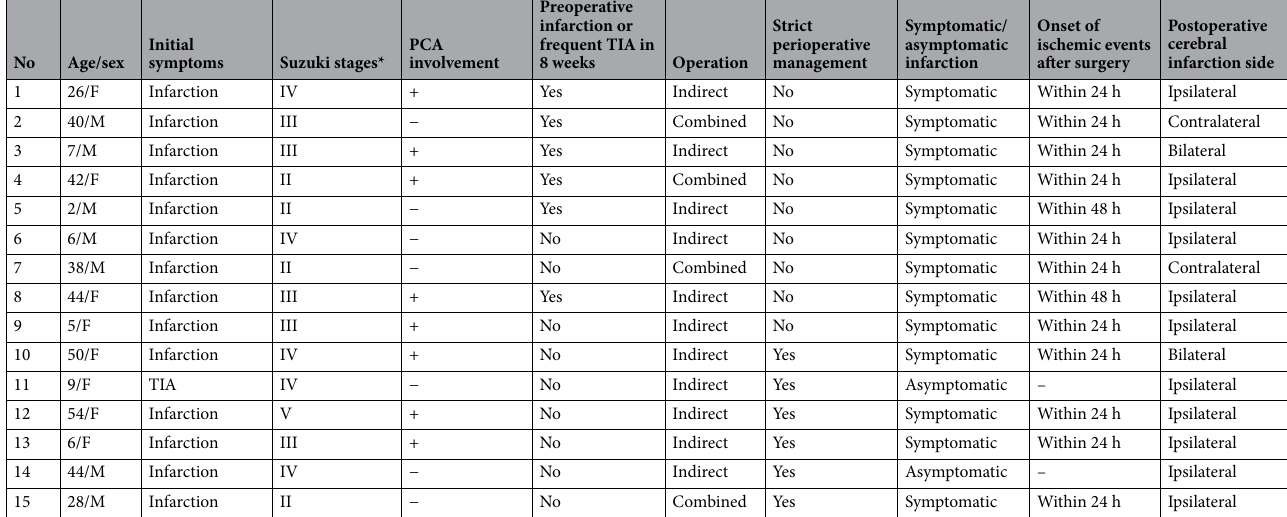
Table 1. Summary of 15 patients with postoperative cerebral ischemic complications. *Preoperative angiographic stages were evaluated using the criteria of Suzuki angiographic stage. PCA posterior circulation artery, TIA transient ischemic attack.